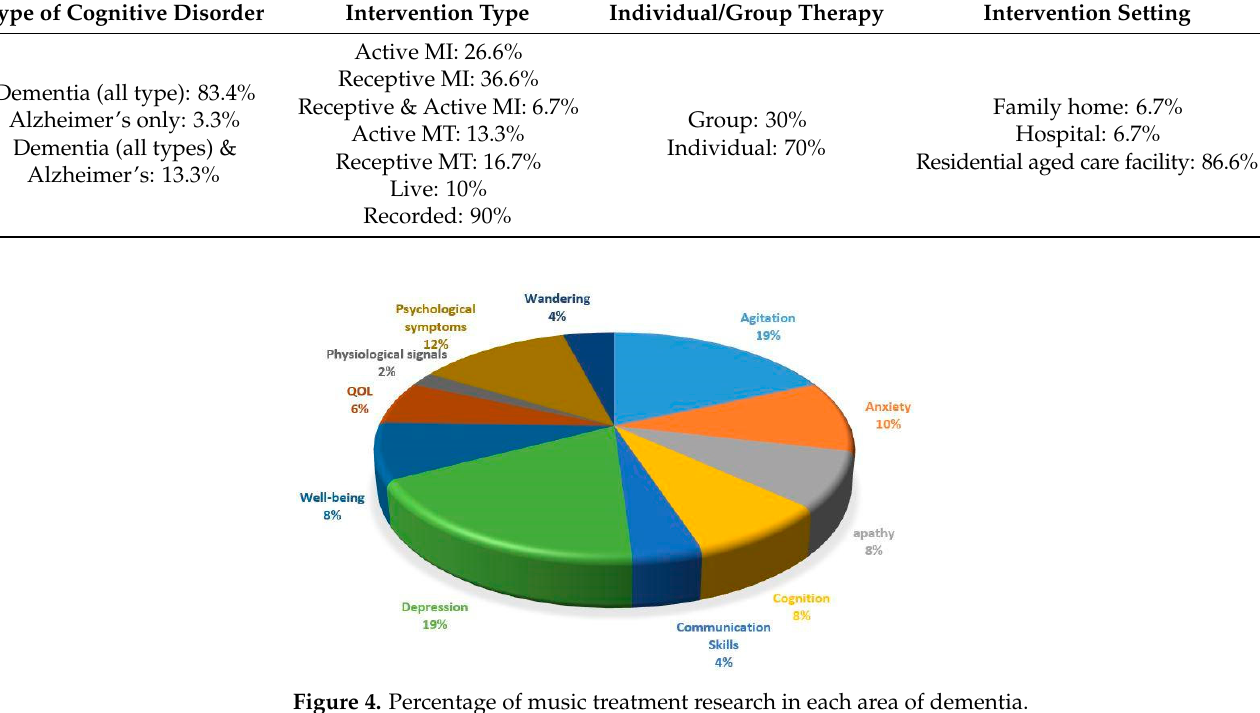
Table 1. Percentage of experiment design based on intervention type, setting, and dementia type music intervention (MI)/music medicine, and music therapy (MT).